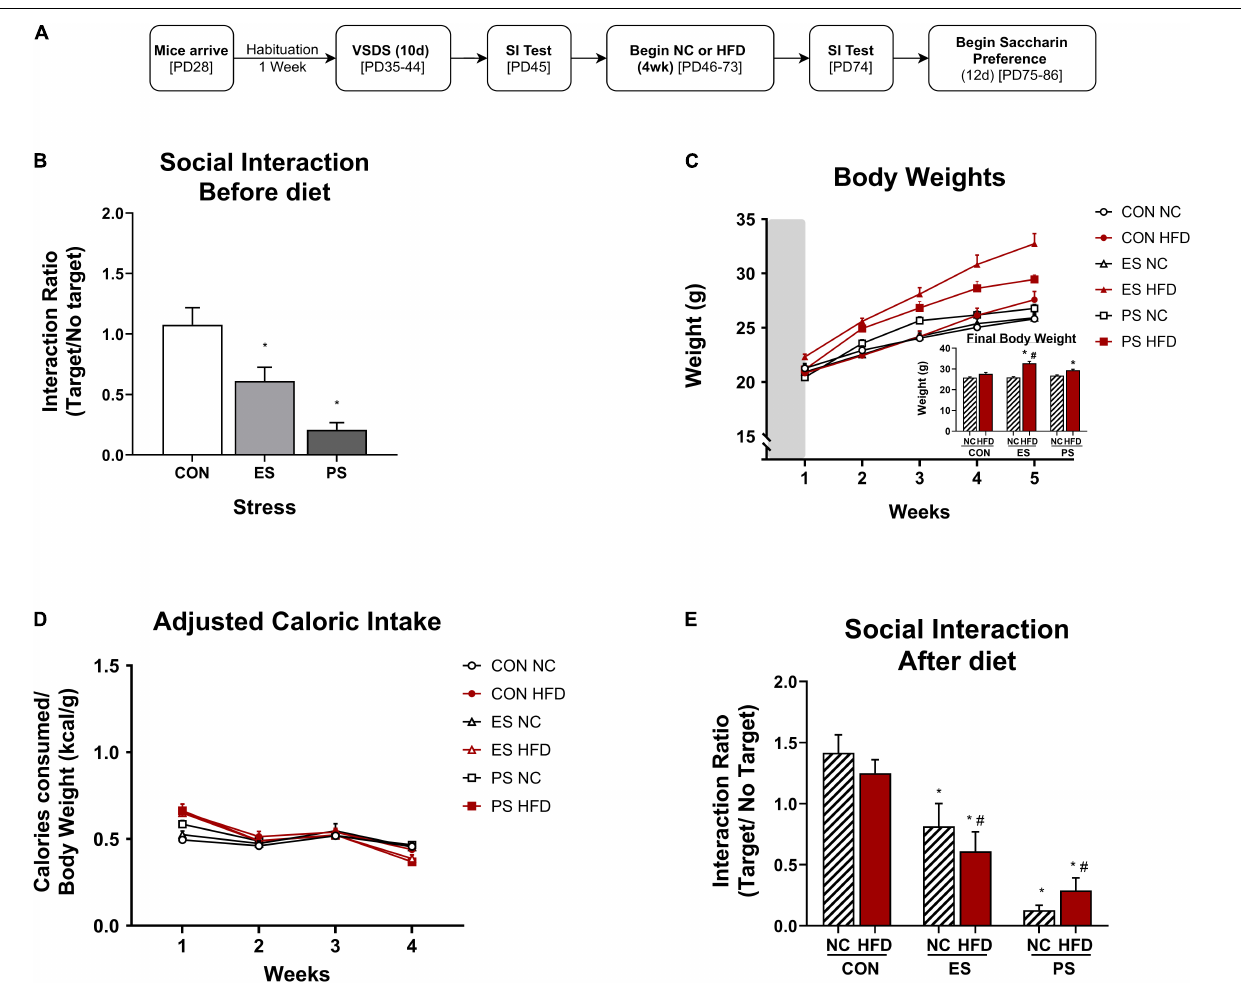
FIGURE 2 | Effects of VSDS exposure prior to 4 weeks of HFD on social interaction, body weight, and caloric intake. (A) Adolescent mice were exposed to the vicarious social defeat stress (VSDS) paradigm and subsequently tested for social interaction. (B) Mice in both the emotional (ES) ( n = 12, p < 0.001) and physical (PS) stress ( n = 12, p < 0.05) condition showed a significant reduction in social interaction when compared to the CON-exposed mice ( n = 12) with a main effect of stress ( p < 0.001). (C) Mice that received HFD in both ES and PS conditions gained weight rapidly and were significantly heavier than the mice in the CON-NC condition during the final week of diet exposure ( post hoc : p < 0.05) and a significant interaction between stress, diet and time (separated n = 6/group, p < 0.05). (D) No differences in adjusted caloric intake between any of the groups in the final week of diet exposure were noted ( post hoc, p > 0.05), though there were significant differences in the first week (main effect of time and stress, p < 0.05). (E) To evaluate the effect of 4 weeks of HFD exposure on social interaction, the mice were exposed to the social interaction test (SIT) 24 h after the last day of diet exposure. Mice in the PS condition retained their defeated phenotype (i.e.,